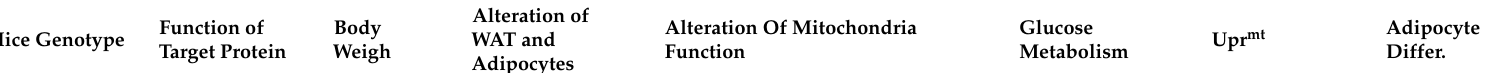
Table 1. Genetically modified mice, which show lipoatrohy due to the defect of proteins involved in mitochondria function.